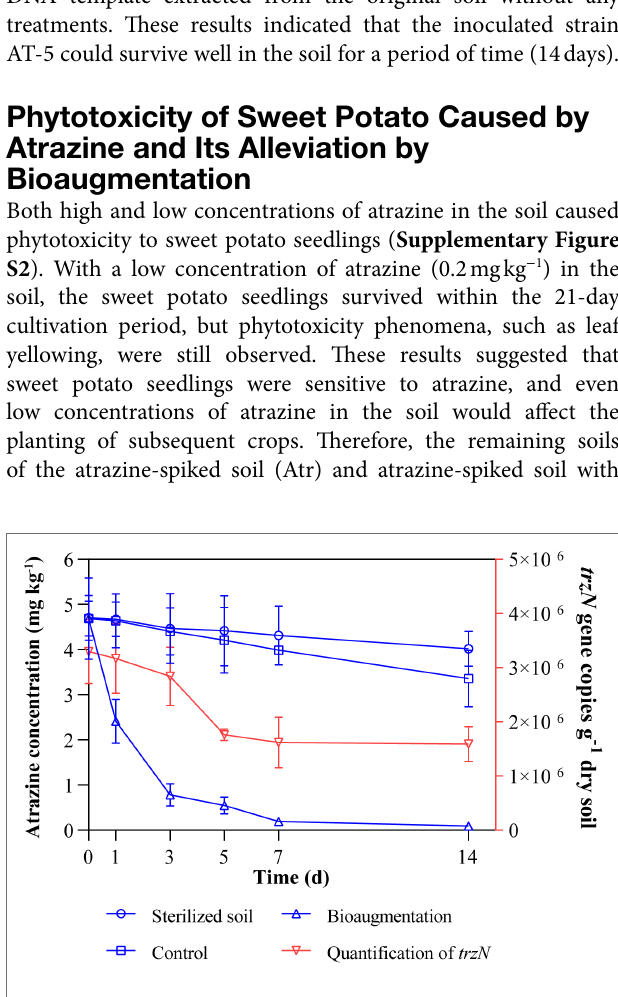
FIGURE 1 | Dissipation of atrazine in various soil samples with time and qRT-PCR quantification of trzN in inoculated soil microcosms. Control: native soil spiked with atrazine; Sterilized soil: sterilized soil spiked with atrazine; Bioaugmentation: atrazine-spiked soil with inoculation of strain AT-5; Quantification of trzN : trzN gene copies (g − 1 dry